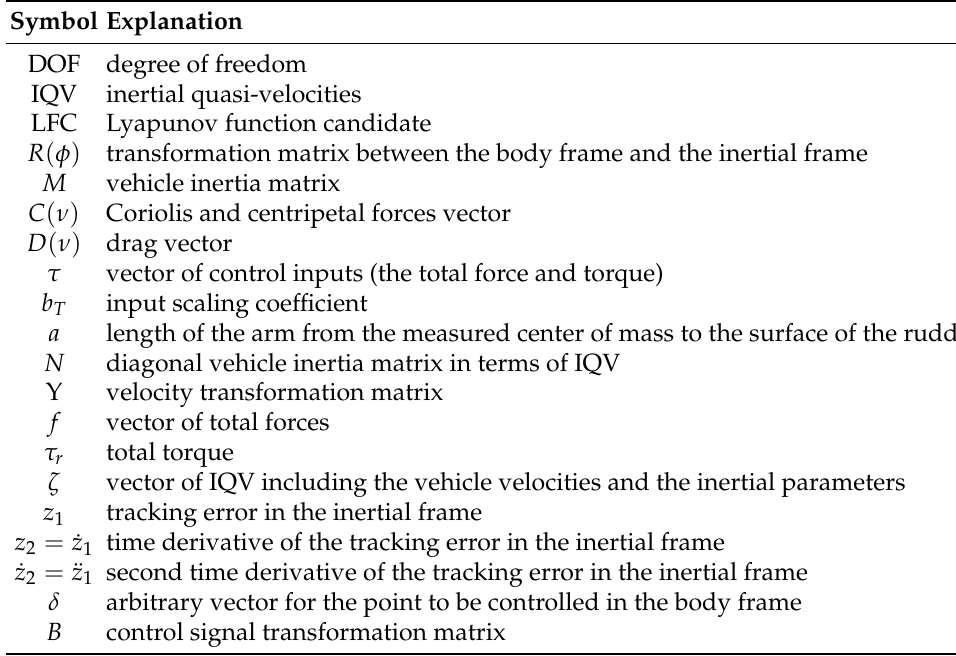
Table A1. Explanation of symbols and